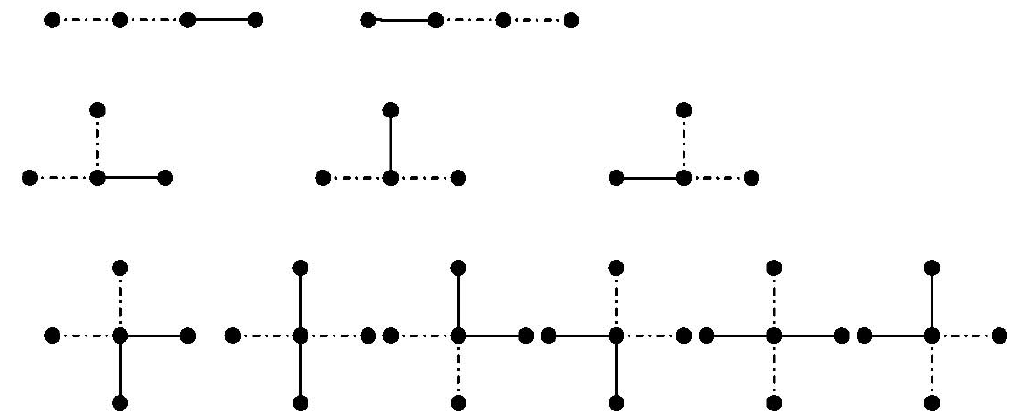
Figure 3. Number of two consecutive bonds up to a branching degree of four.